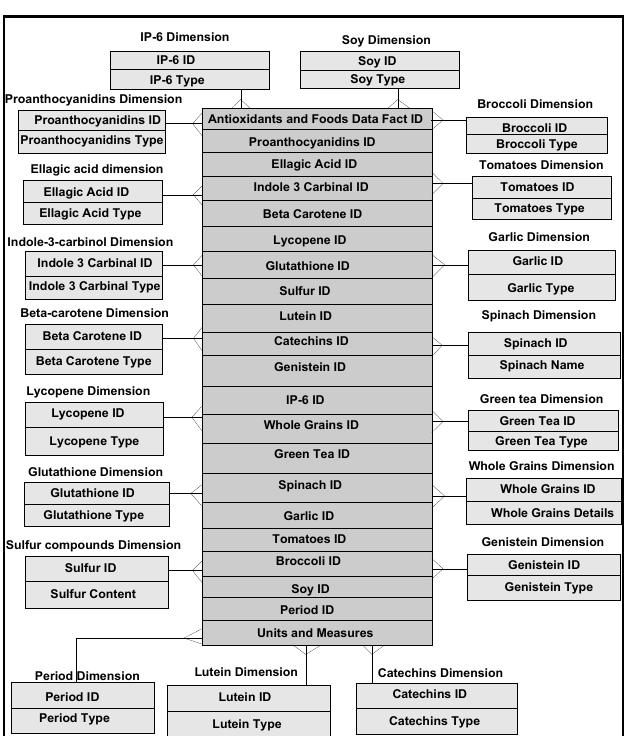
Figure 5. Multidimensional modeling of data instances relevant to antioxidants and their associated foods affecting the blood